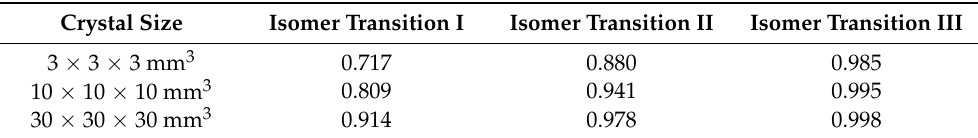
Table 4. Dependency of the total photo-peak ratio according to the crystal